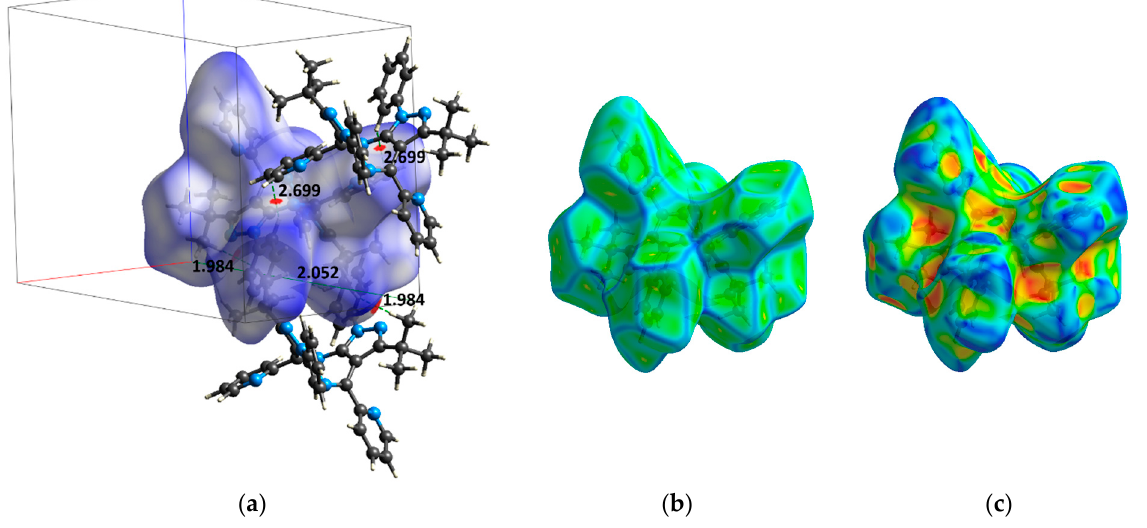
Figure 5. Hirshfeld surface (HS) of a crystal 8 molecule mapped over ( a ) the normalized contact distance ( d norm ) scaled over the range 0.5–1.7, ( b ) curvedness ( C ) scaled over the range − 4.0–0.4, and ( c ) shape index ( S ) scaled over the range −